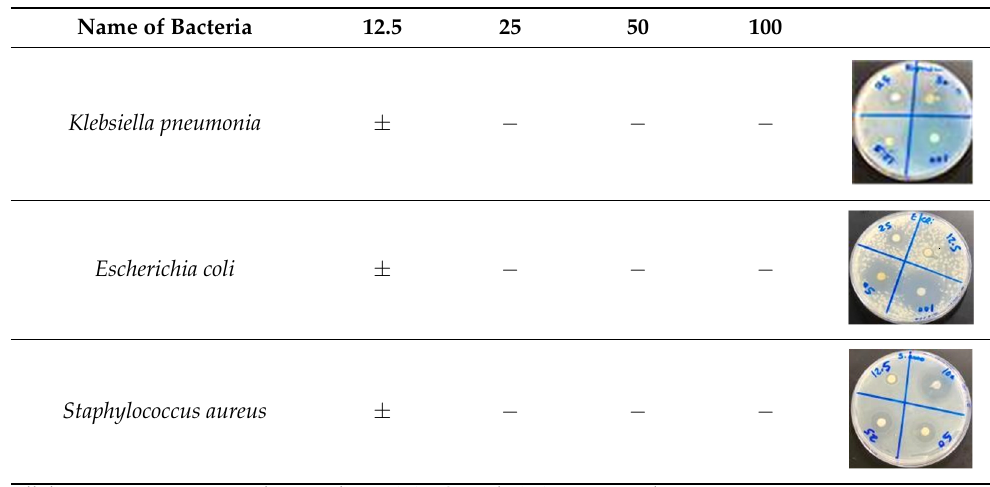
Figure 10. TGA-DTA curves for (C 9 H 14 N) 2 [CuCl 4 ]. Table 6. MIC of different dilutions of (C 9 H 14 N) 2 [CuCl 4 ].Growth in nutrient agar containing different concentrations (C 9 H 14 N) 2 [CuCl 4 ] ( µ g mL − 1 ).